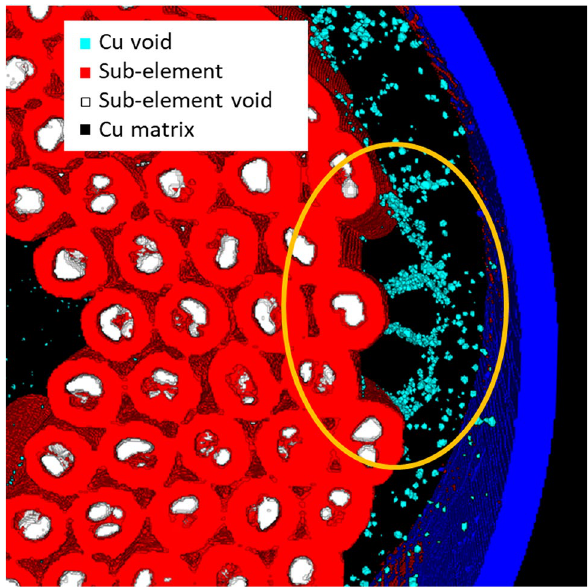
Figure 7. The 3D reconstruction of sample S19. The sub-elements and their voids are in red and white, respectively. The blue wall represents the wire edge, while the Cu voids are in light blue. The orange circle underlines three sets of Cu voids formed around hexagonal Cu rods used to fil the space between the sub- elements and the outer copper tube. The image was generated by using the Fiji distribution of ImageJ 40 . [ImageJ- 1.53c https:// imagej. net/ ImageJ ].